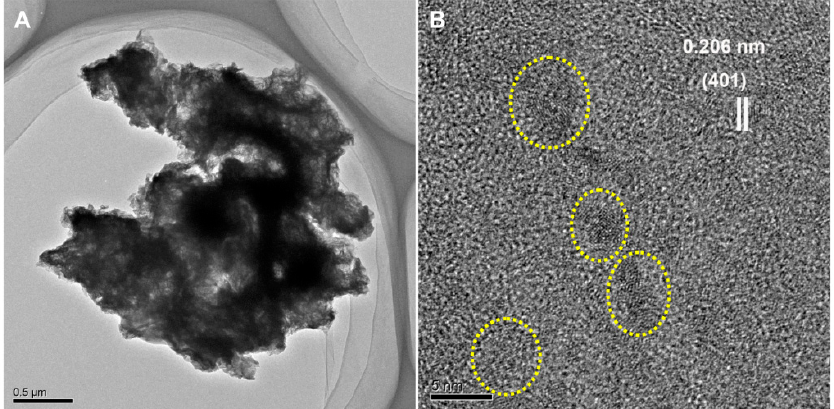
Figure 3. ( A ) Typical HRTEM images of a randomly selected BMO aggregate particle; ( B ) measured lattice spacings of the micro-/nanostructured BMO aggregate matter.